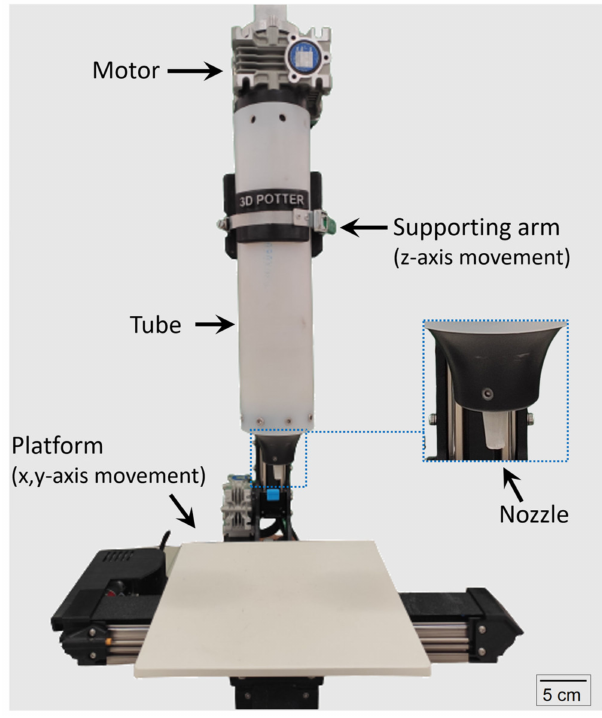
Figure 2. 3D printer setup